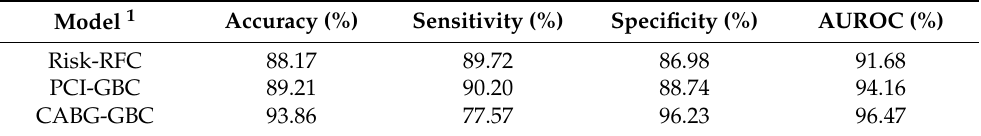
Table 7. Performance of models trained after feature